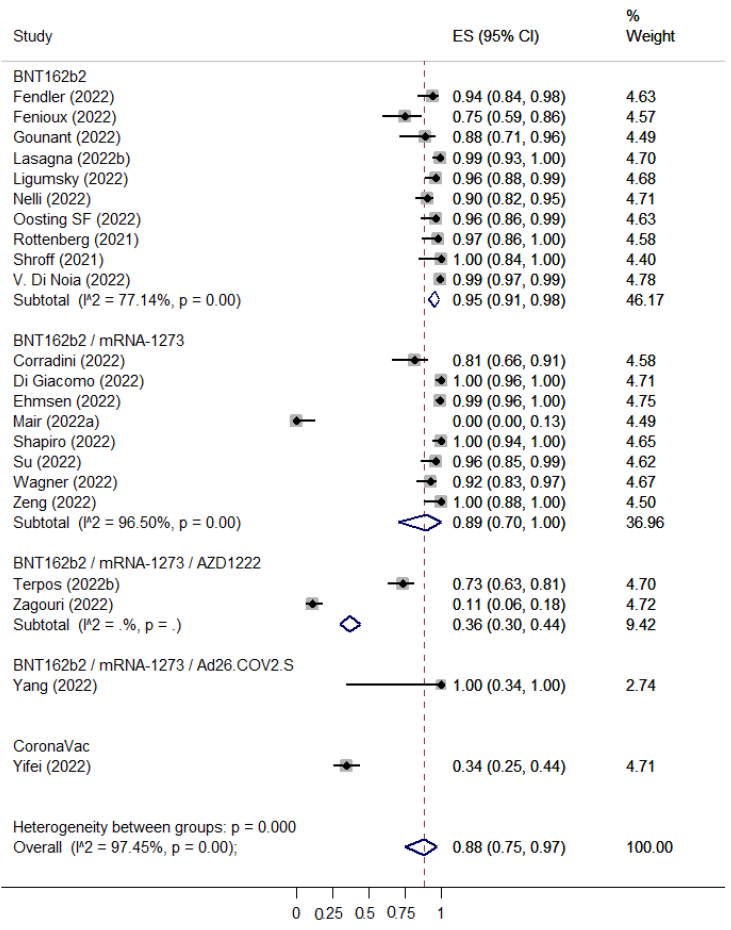
Figure 8. Pooled EffectSize (ES) for the immune seroconversion rates of patients with solid tumors after the third dose of COVID-19 vaccine.